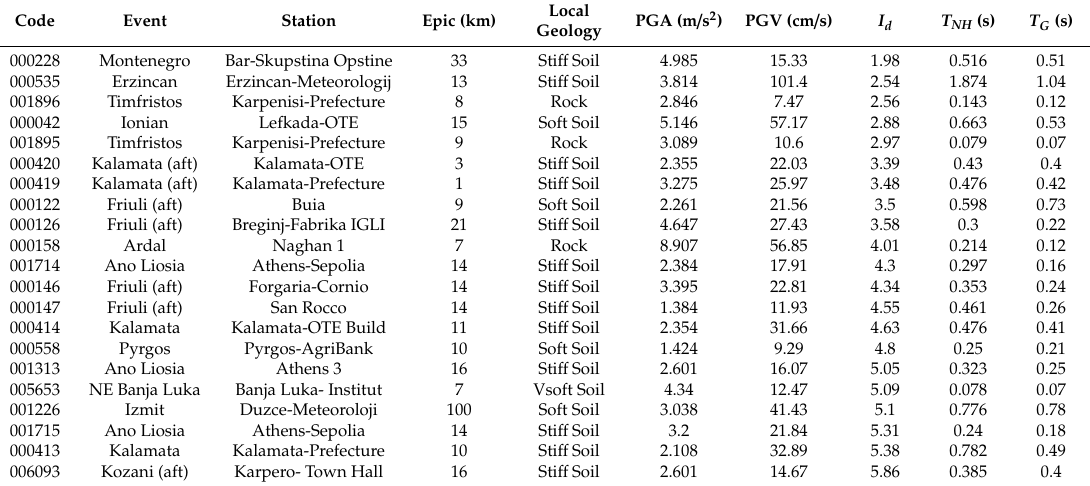
Table A1. Properties of ground motion in the near-fault